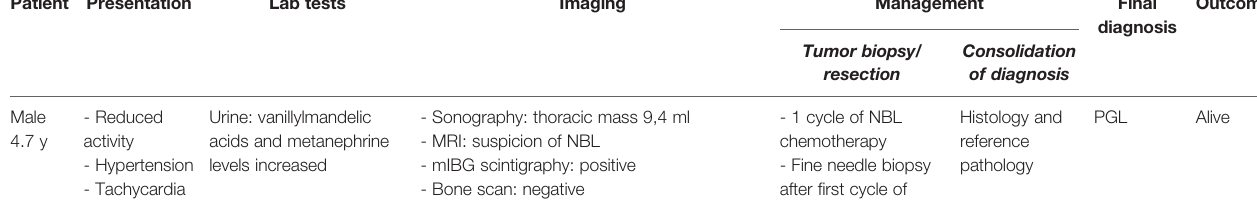
TABLE 2 | Demographic details and clinical presentation in 5 children and adolescents with pheochromocytoma and paraganglioma initially mistaken as neuroblastoma. Patient